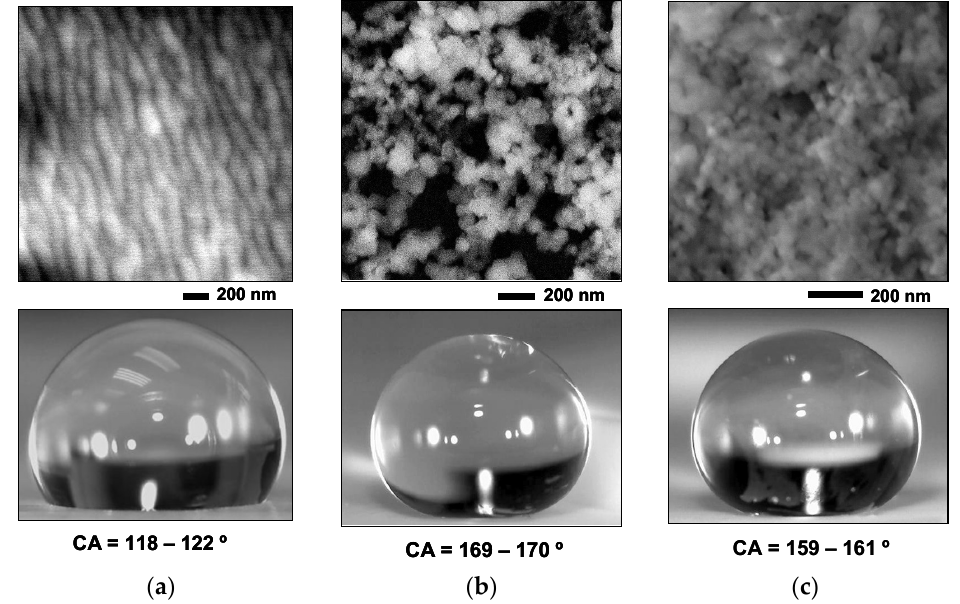
Figure 1. SEM image of unmodified ( a ) and pp-HMDS film modified PDMS surfaces ( b , c ) and water droplets on PDMS surface before and after pp-HMDS film deposition at different times: ( a ) 0; ( b ) 30 s; ( c ) 60 s.